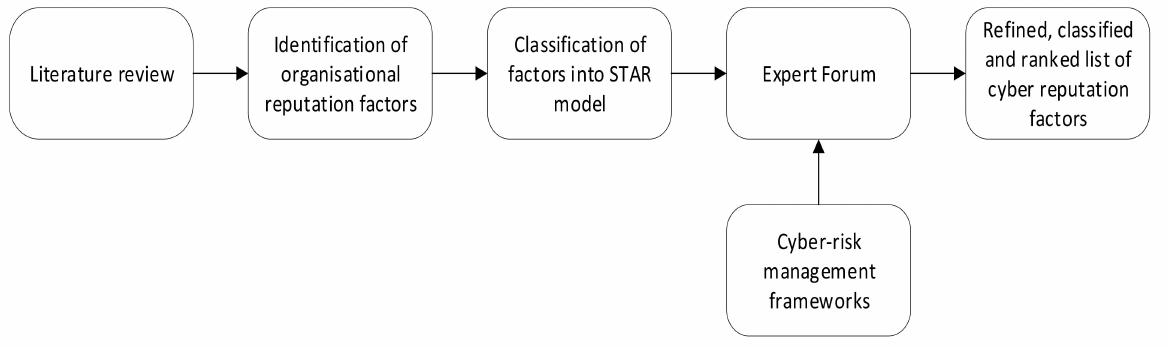
Figure 1. An overview of the research process used in the